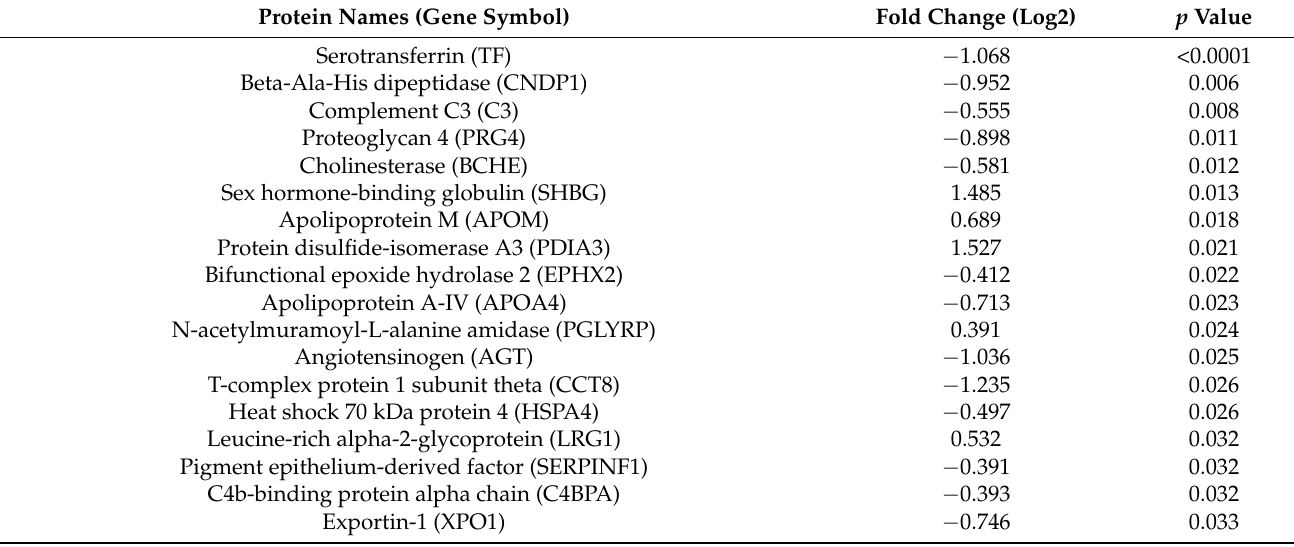
Figure 1. Principal component analysis of all identified proteins. Pre-surgery samples are coloured in blue, 6-month post-surgery samples in green and 12-month post-surgery samples in red. Table 2. Proteins showing a significant difference in expression between baseline and six months post-surgery.